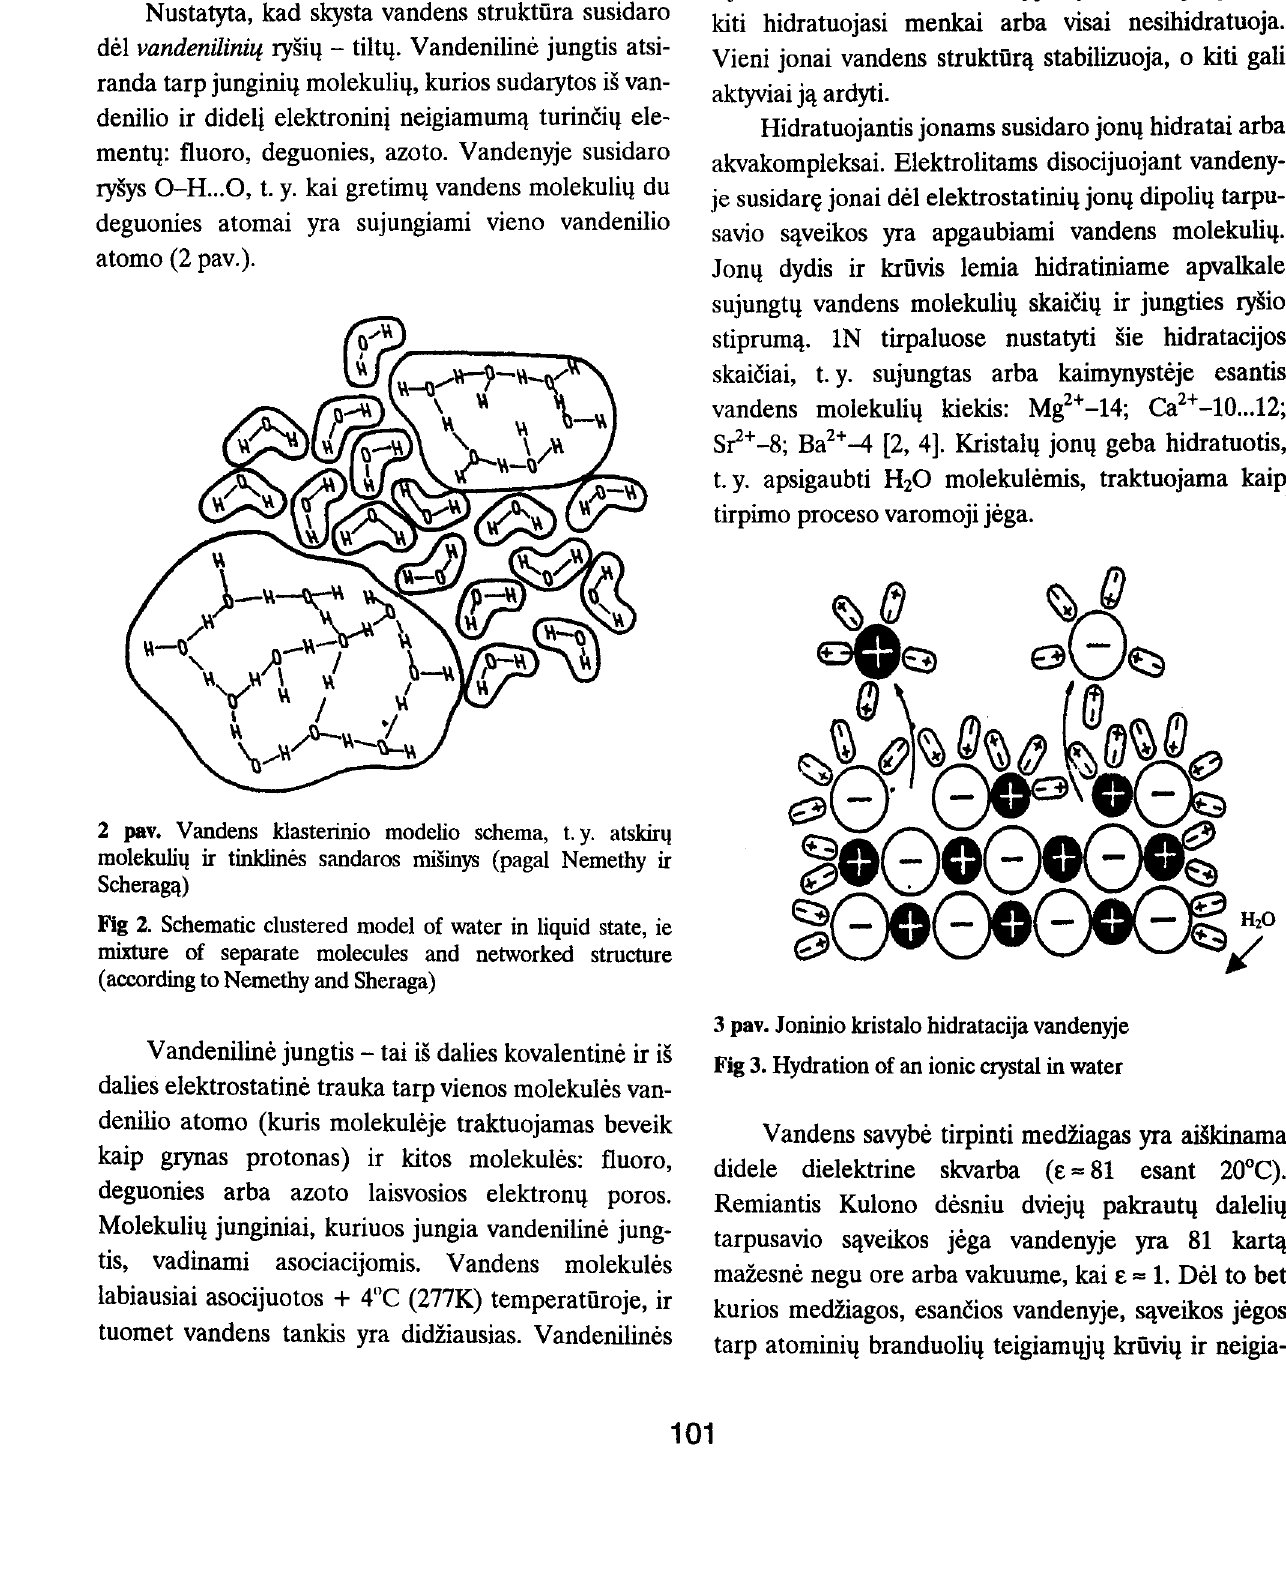
Fig 3. Hydration of an ionic crystal in